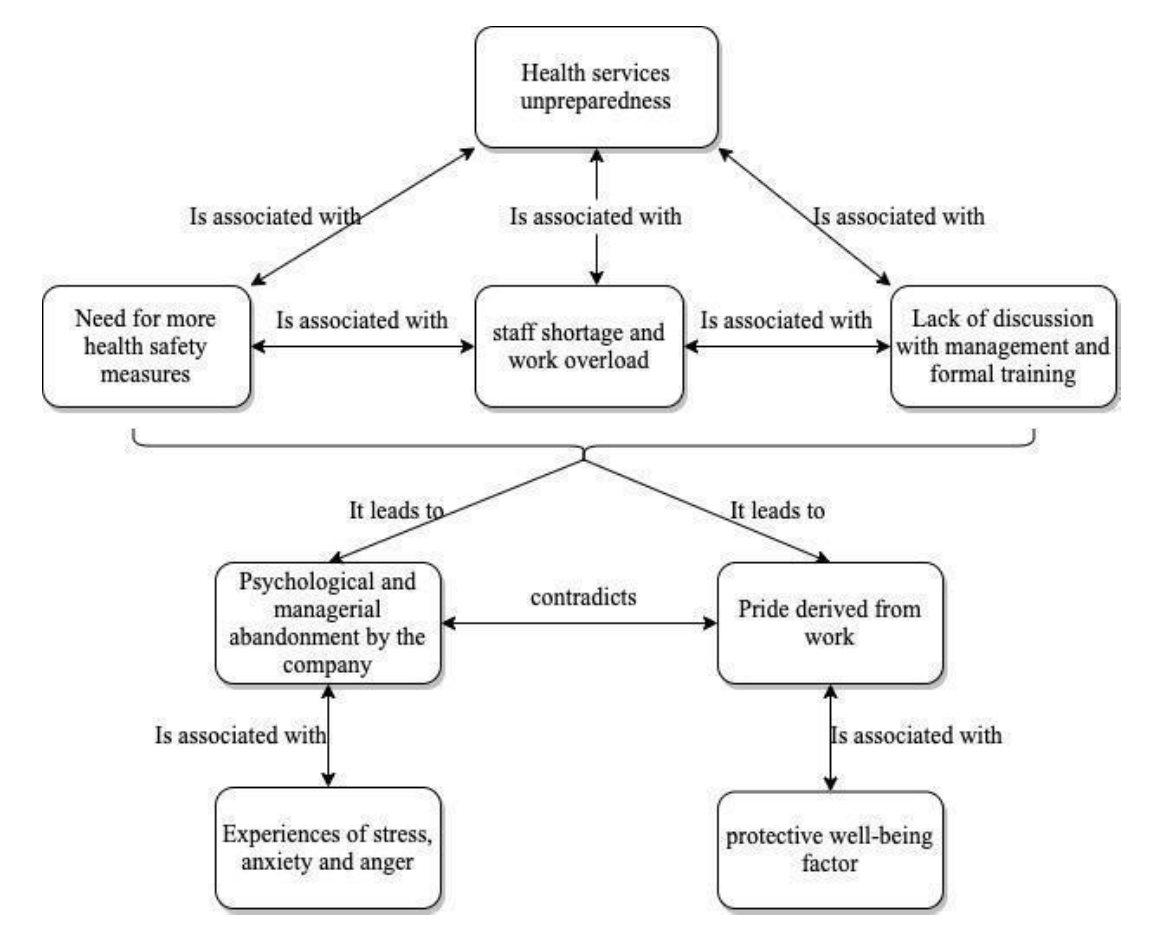
Figure 1. Relationship with the company.